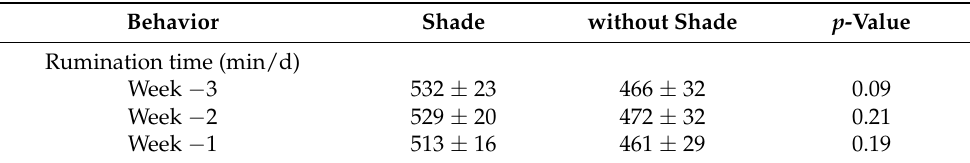
Table 2. Cont. Behavior Shade without Shade p -Value Rumination time (min/d)